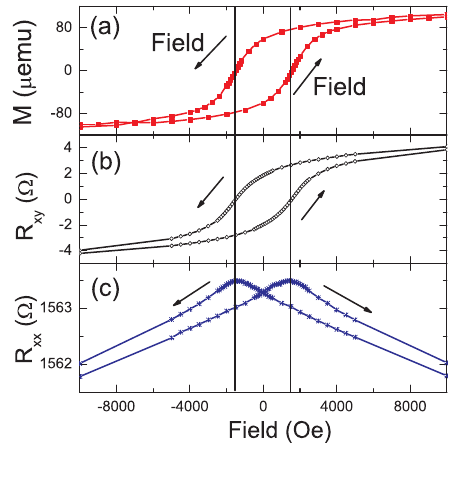
Figure 12 . The field dependent (a) magnetization ( M ), (b) Hall resistance ( R longitudinal resistance ( R ) of the Ge:Mn system at 5 K. Hysteresis appears for both R xx and R curves, with the same coercivity as for M . The longitudinal resistivity is around xy 0.015 Ω -cm if assuming a thickness of 100 nm. (Reprinted with permission from Ref. [60]. Copyright 2010 by the American Physical